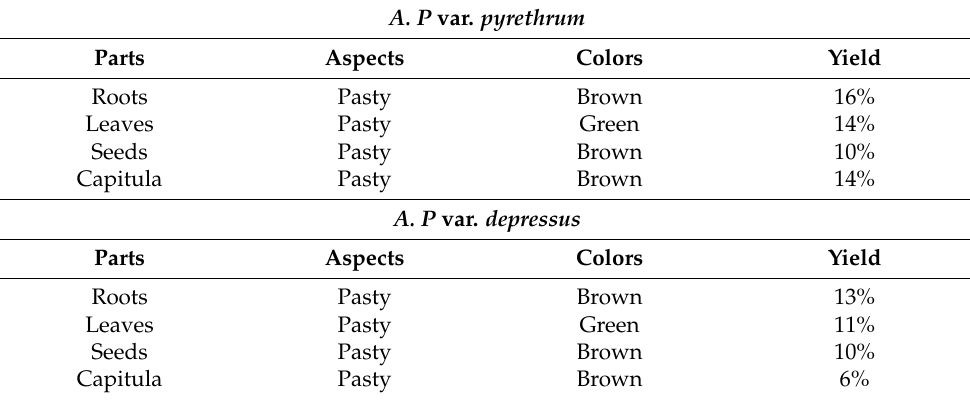
Table 1. Aspects, colors, and yields of extracts from A. P var. pyrethrum (L.) and A. P var. depressus (Ball) Maire.